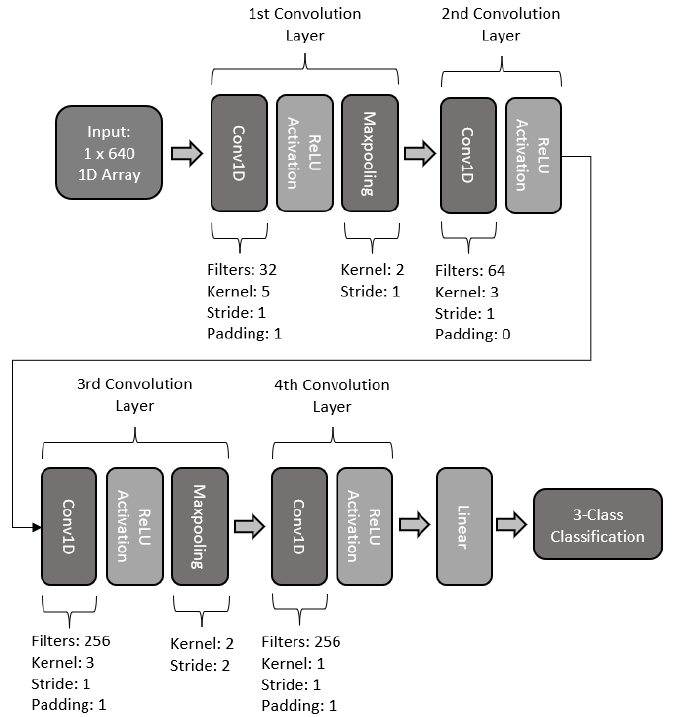
Figure 18. Architecture of four-layer 1D CNN